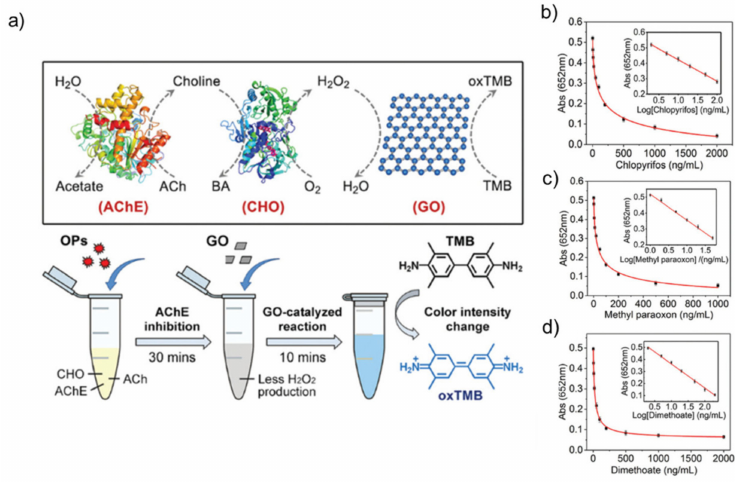
Figure 14. Chemoenzymatic cascade process as a pesticide biosensor. ( a ) General scheme of the strategy. ( b – d ) Dose–response curve and semilogarithmic plot (inset) for OP detection: chlorpyrifos, methyl paraoxon and dimethoate. Figure adapted from Ref.